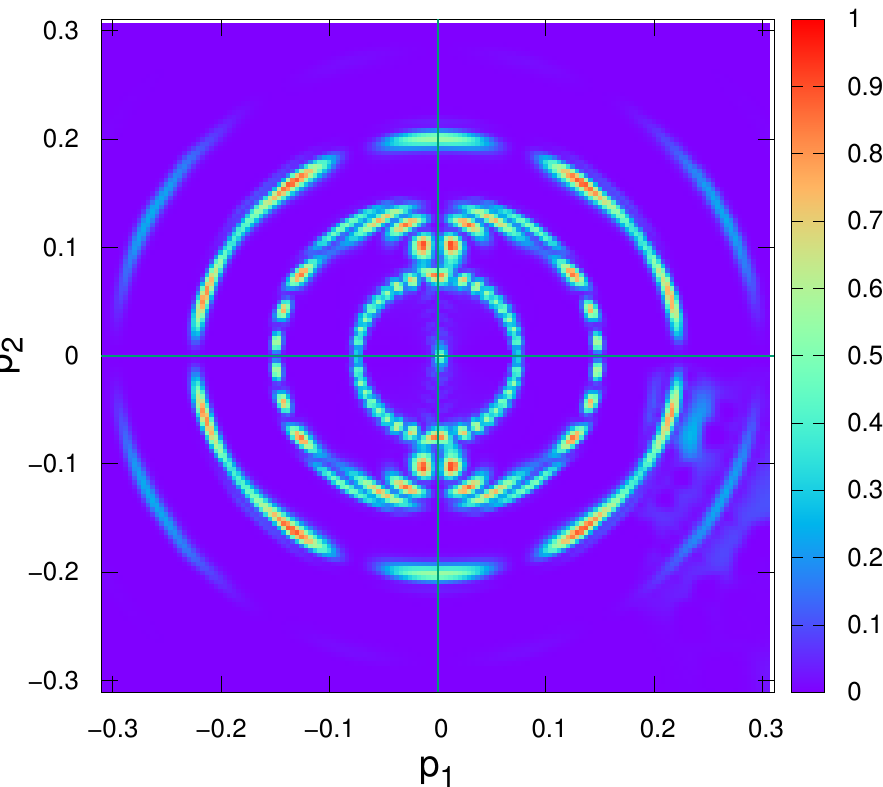
Figure 9. Momentum space distribution function f ( p 1 , p 2 ) at the final stage of the action of the external